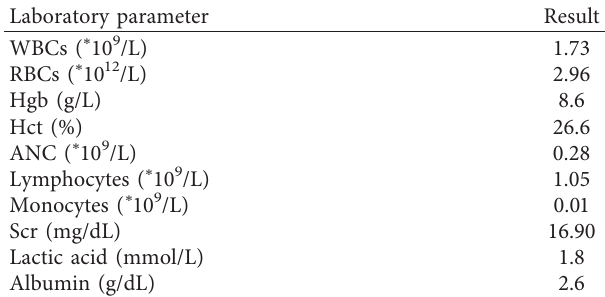
Table 1: Laboratory results on